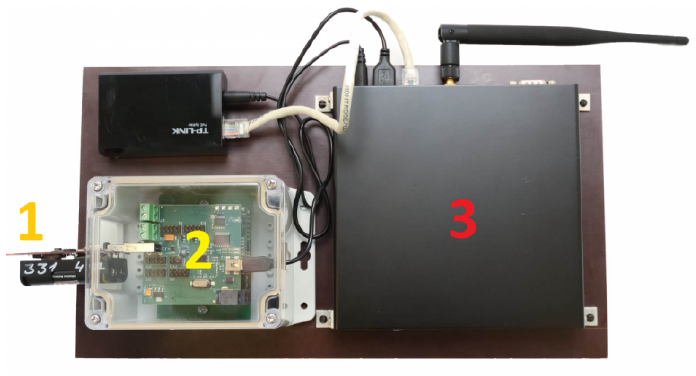
Figure 1. EDI TestBed workstation